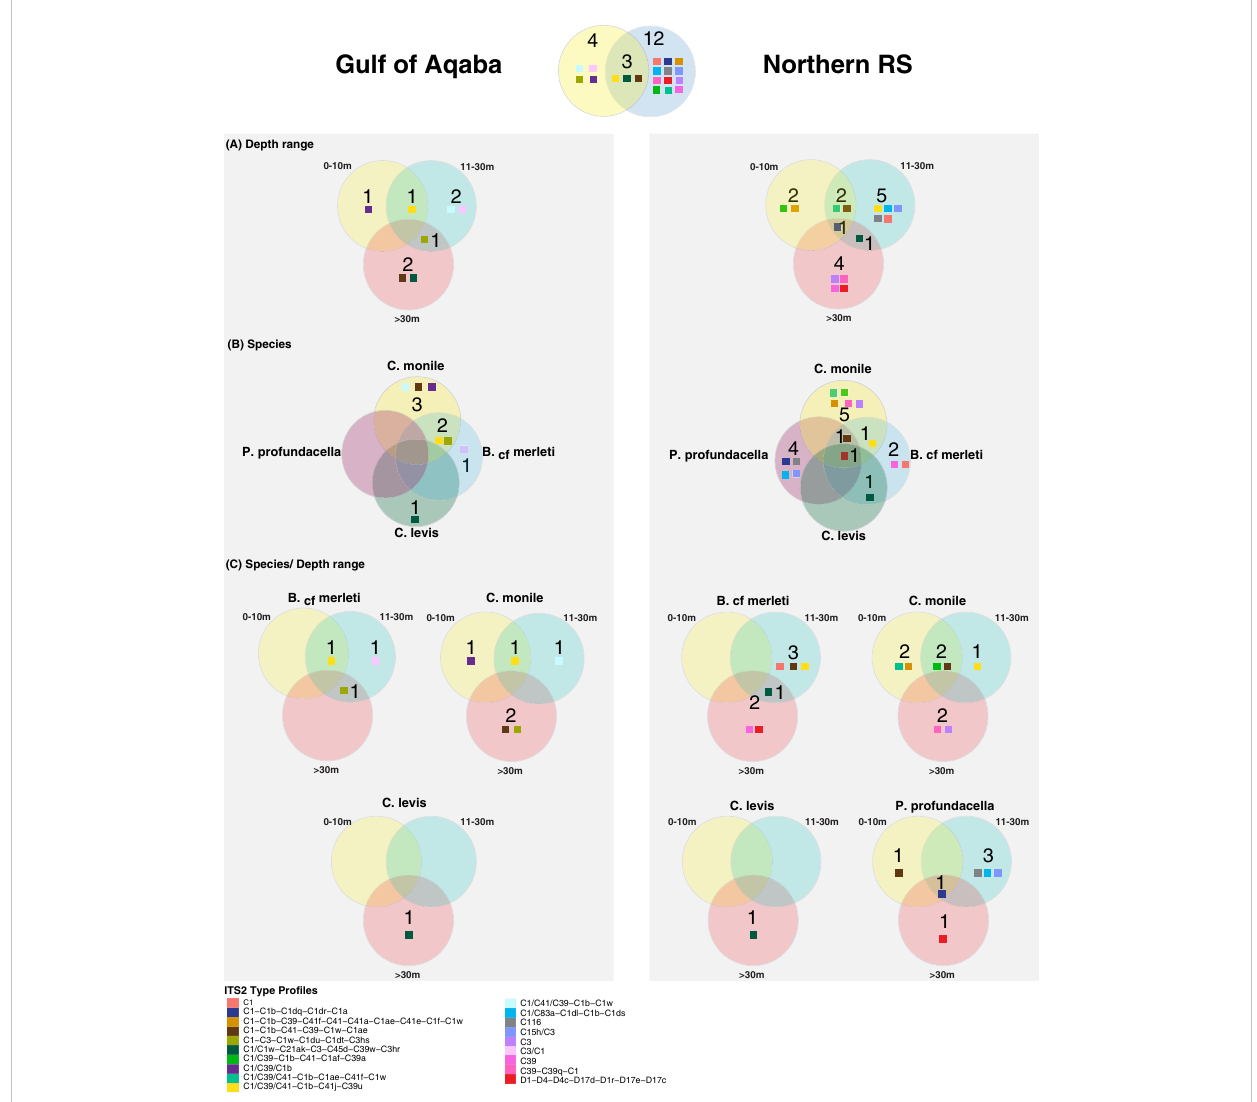
FIGURE 5 Venn diagrams representing the unique and shared Symbiodiniaceae ITS2 pro fi les in the Gulf of Aqaba and the northern Red Sea over (A) depth range, (B) species, and (C) species/depth range. Colored squares refer to Symbiodiniaceae ITS2 pro fi les as outlined in the